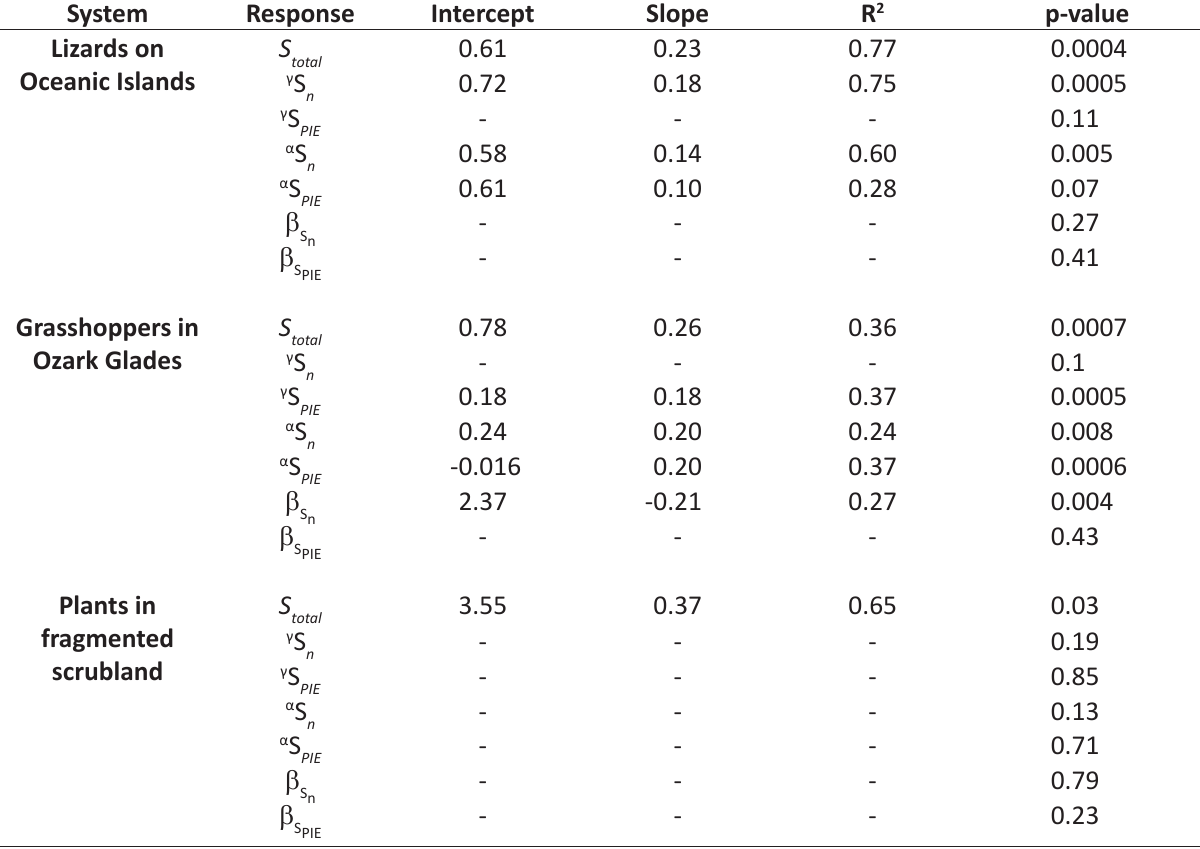
Table 2: Linear regression coefficients and fits for each response in each case study. In all cases, log(area) was the explanatory variable against the log of the diversity measure. Coefficients are given only when the slope was significantly different from